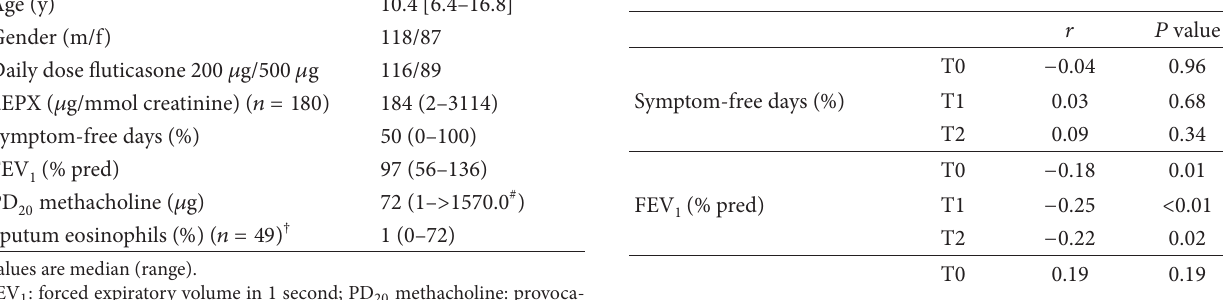
T 1: Characteristics of the 205 children at baseline. T 2: Correlations between uEPX and clinical markers of asthma.